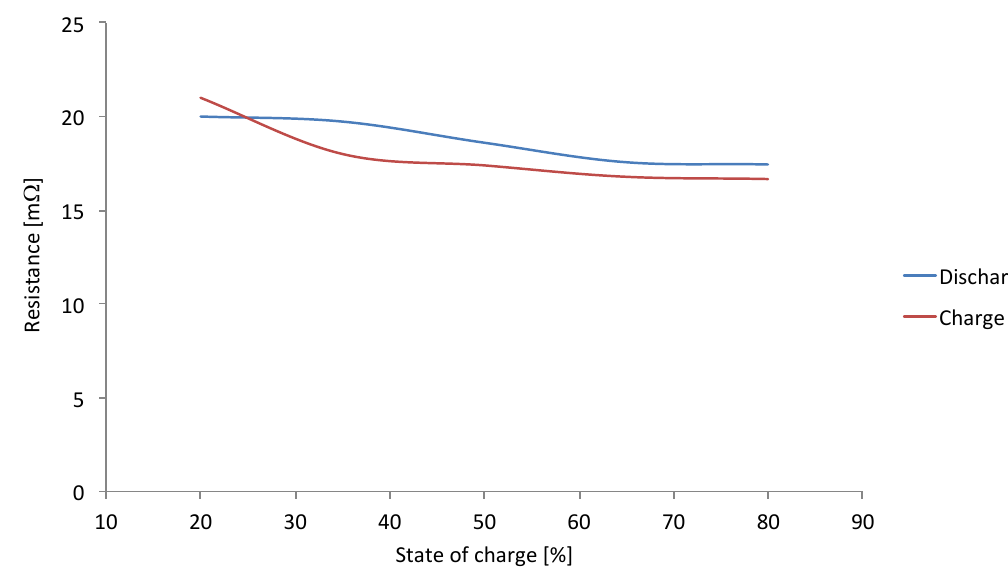
Figure 32. Evolution of internal resistance during charge and discharge (battery brand